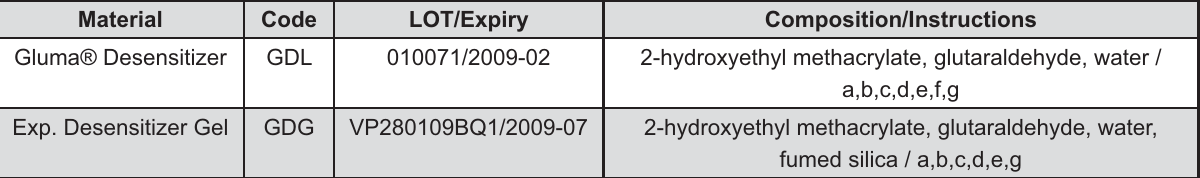
Figure 2- Materials tested and application